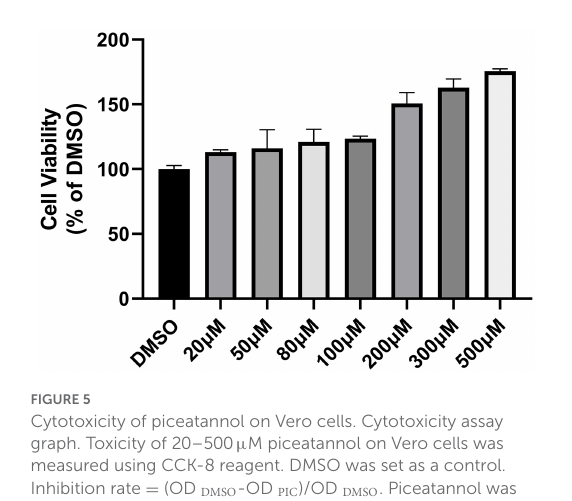
FIGURE5 Cytotoxicity of piceatannol on Vero cells. Cytotoxicity assay graph. Toxicity of 20–500 µ M piceatannol on Vero cells was measured using CCK-8 reagent. DMSO was set as a control. Inhibition rate = (OD DMSO -OD PIC )/OD DMSO . Piceatannol was not toxic to Vero cells. This experiment was performed in